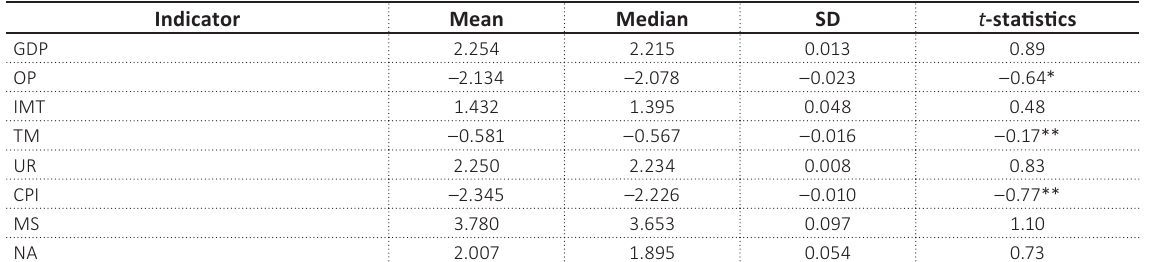
Table 6. Results of mean, median, and t -test